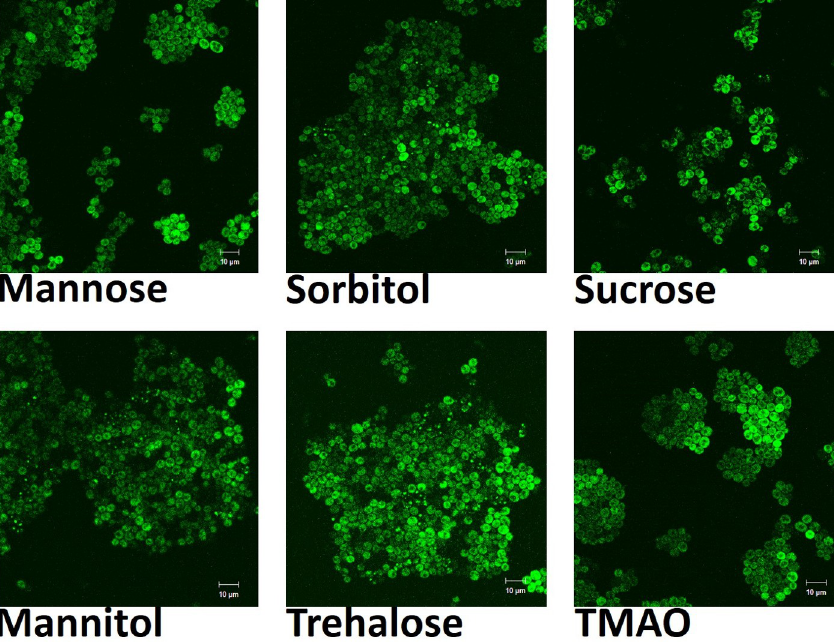
Fig 4. Confocal imaging of yeast cells under stress with different osmolytes. Mannose, mannitol, sucrose, sorbitol, trehalose and TMAO were used as osmolytes in our study. All these osmolytes were able to alleviate the effects of stress on the yeast cells of the wild type strain. The yeast cells had aggregates and they looked bright under the confocal microscope.